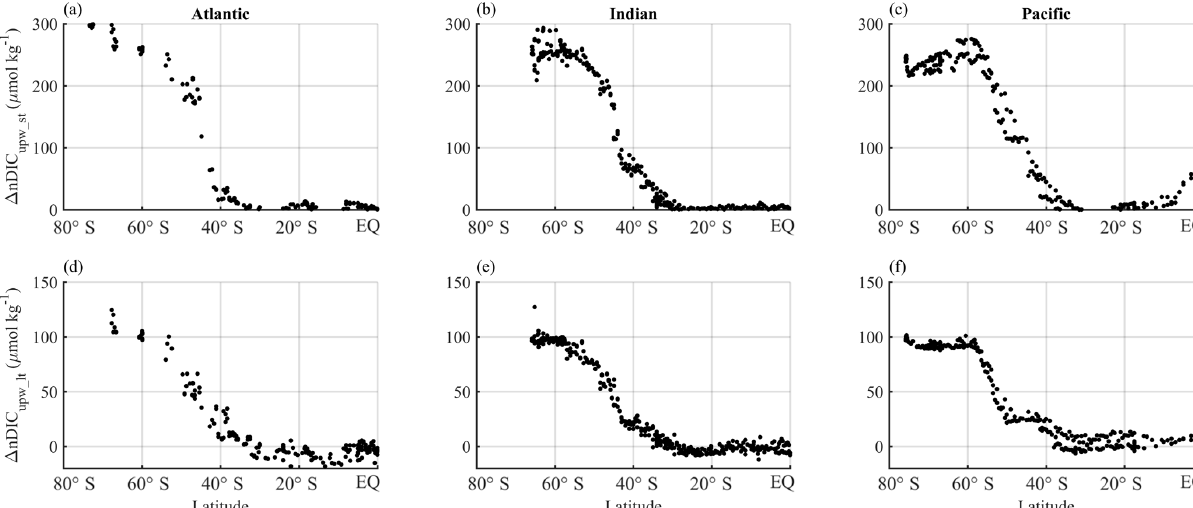
Figure 8. Latitudinal distributions of calculated upwelling effects on surface nDIC. Different columns show different sectors in ocean basins (Atlantic, Indian, and Pacific) and different rows show different calculated effects on surface DIC. Panels (a) , (b) , and (c) show the short- term effect of upwelling ( (cid:49) nDIC upw_st ), which is driven by the direct supply of DIC from deep water and subsequent change by biology in the Southern Ocean. Panels (d) , (e) , and (f) show the long-term effect of upwelling ( (cid:49) nDIC upw_lt ), which is the difference between the observed nDIC value (determined mainly by the amount of upwelled TA, as well as by SST) and pre-upwelling nDIC value. The results were calculated from the three selected transects defined in Sect.